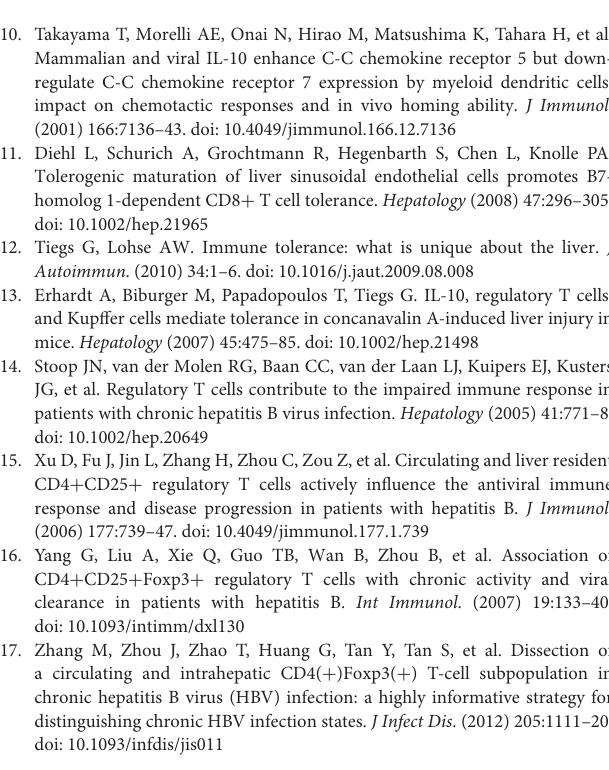
Supplementary Figure 1 | Comparison of plasma viral loads (log 10 ) and liver enzyme levels (ALT, AST, and GGT) among − 2383C > T polymorphism genotype individuals in CHC patients with absent to mild and moderate to severe inflammatory activity. Reference values: ALT (8-54 IU/L), AST (16-40 IU/L), and GGT (8-63 IU/L). Supplementary Figure 2 | Comparison of plasma viral loads (log 10 ) and liver enzyme levels (ALT, AST, and GGT) among − 2383C > T polymorphism genotype individuals gene in CHC patients with absent to mild liver fibrosis, fibrosis with few septa and advanced fibrosis to cirrhosis. Reference values: ALT (8-54 IU/L), AST (16-40 IU/L), and GGT (8-63 IU/L). Supplementary Figure 3 | Comparison of plasma viral loads (log 10 ) and liver enzyme levels (ALT, AST, and GGT) among − 2383C > T polymorphism genotype individuals in CHB patients with absent to mild and moderate to severe inflammatory activity. Reference values: ALT (8-54 IU/L), AST (16-40 IU/L), and GGT (8-63 IU/L). Supplementary Figure 4 | Comparison of plasma viral loads (log 10 ) and liver enzyme levels (ALT, AST and GGT) among − 2383C > T polymorphism genotype individuals in CHB patients with absent to mild liver fibrosis, fibrosis with few septa and advanced fibrosis to cirrhosis. Reference values: ALT (8-54 IU/L), AST (16-40 IU/L) and GGT (8-63